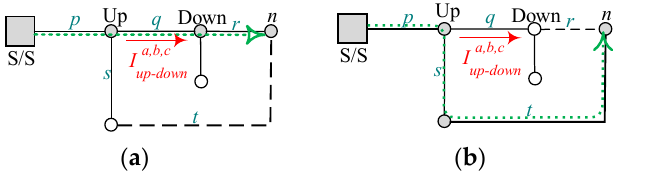
Figure 2. Load flow paths ( a ) before and ( b ) after the distribution network